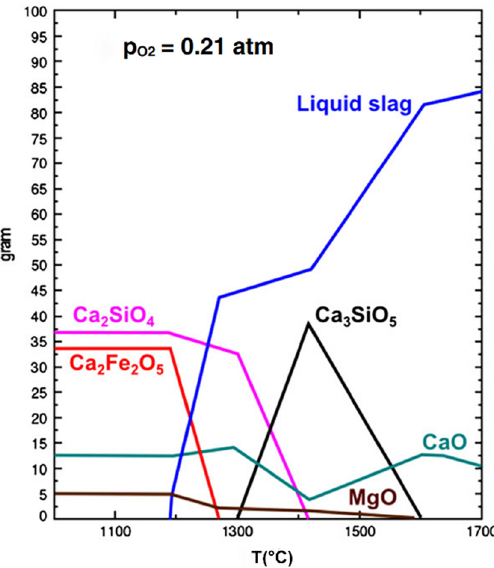
Figure 3. Steel slag phase content changes with temperature [41], adapted from [41], with permission from Elsevier, 2021.